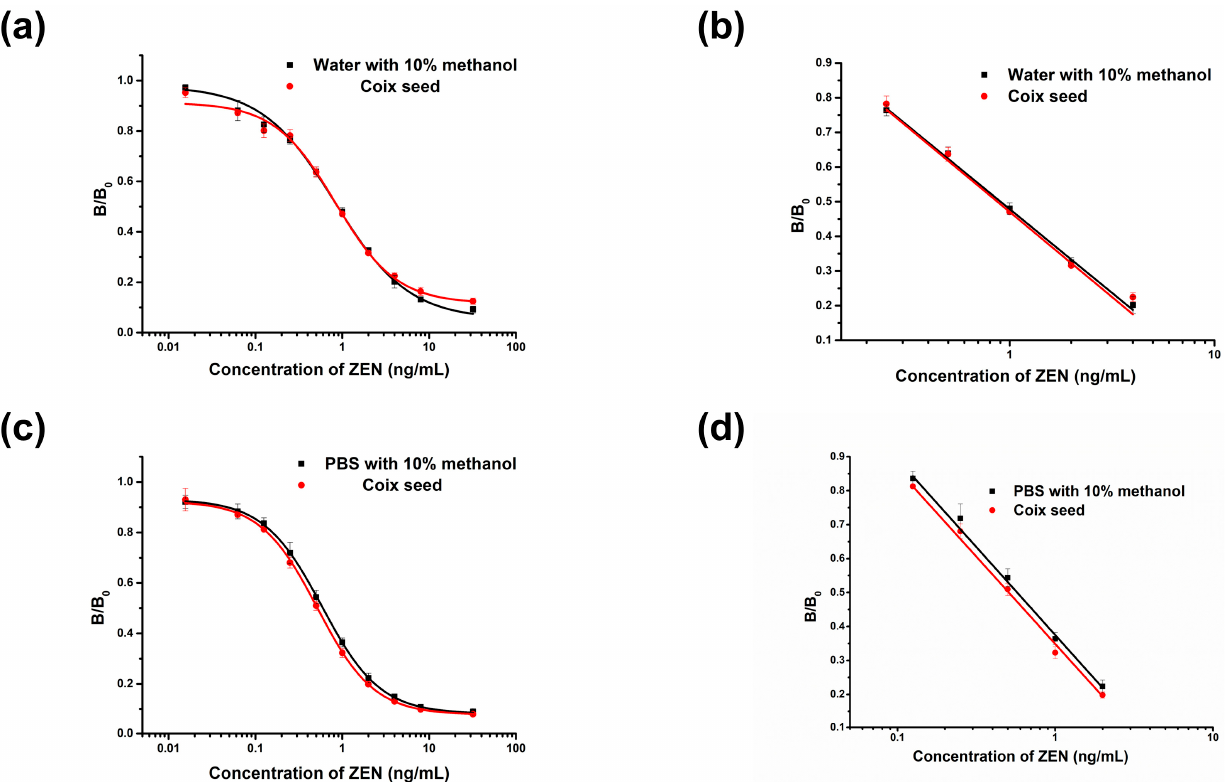
Figure 3. The ic-ELISA calibration curves for zearalenone (ZEN) determination in coix seed. Each data point represents the mean of three parallel experiments. ( a , c ) inhibition curves were generated using a four-parameter logistic fit for MRL 60 µ g/kg and MRL µ g/kg, respectively; ( b , d ) the linear parts of the curves were fitted by the least square method for MRL 60 µ g/kg and MRL 500 µ g/kg, respectively.